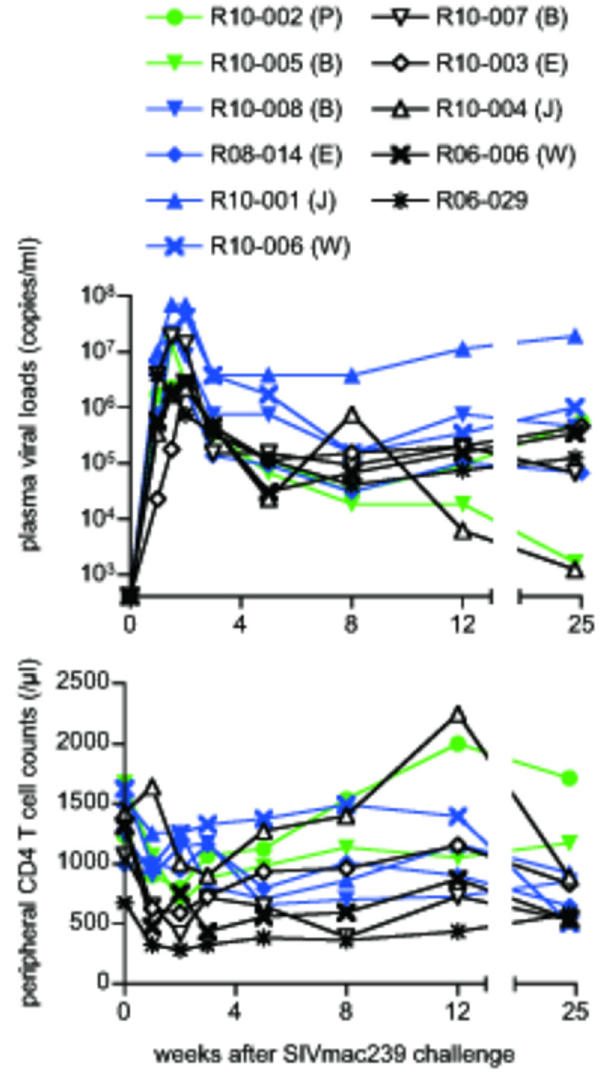
Figure 4. Passive non-NAb immunization in SIV infection. Upper panel: plasma viral loads after SIV challenge (SIV RNA copies/ml in plasma) in two unimmunized (green lines), four control IgG-immunized (blue), and five non- NAb-immunized macaques (black). Viral loads were